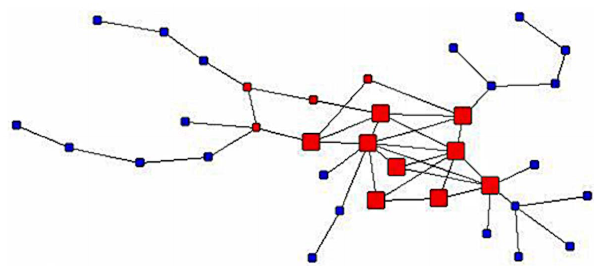
Figure 3. The largest fully connected component of the collaboration network of Romanian sociologists. The largest bi- component is marked red, while the core researchers are denoted using bigger red squares. The later identify the core-periphery structure, as detected within the main